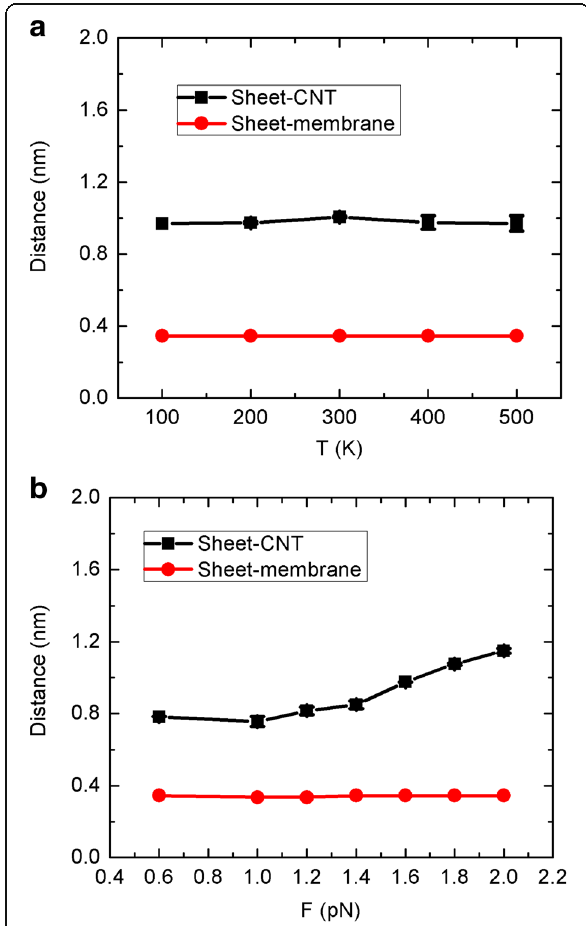
Fig. 9 The mean distance of sheet-membrane and sheet-CNT for different simulation conditions: a Brownian motion and b unidirectional motion